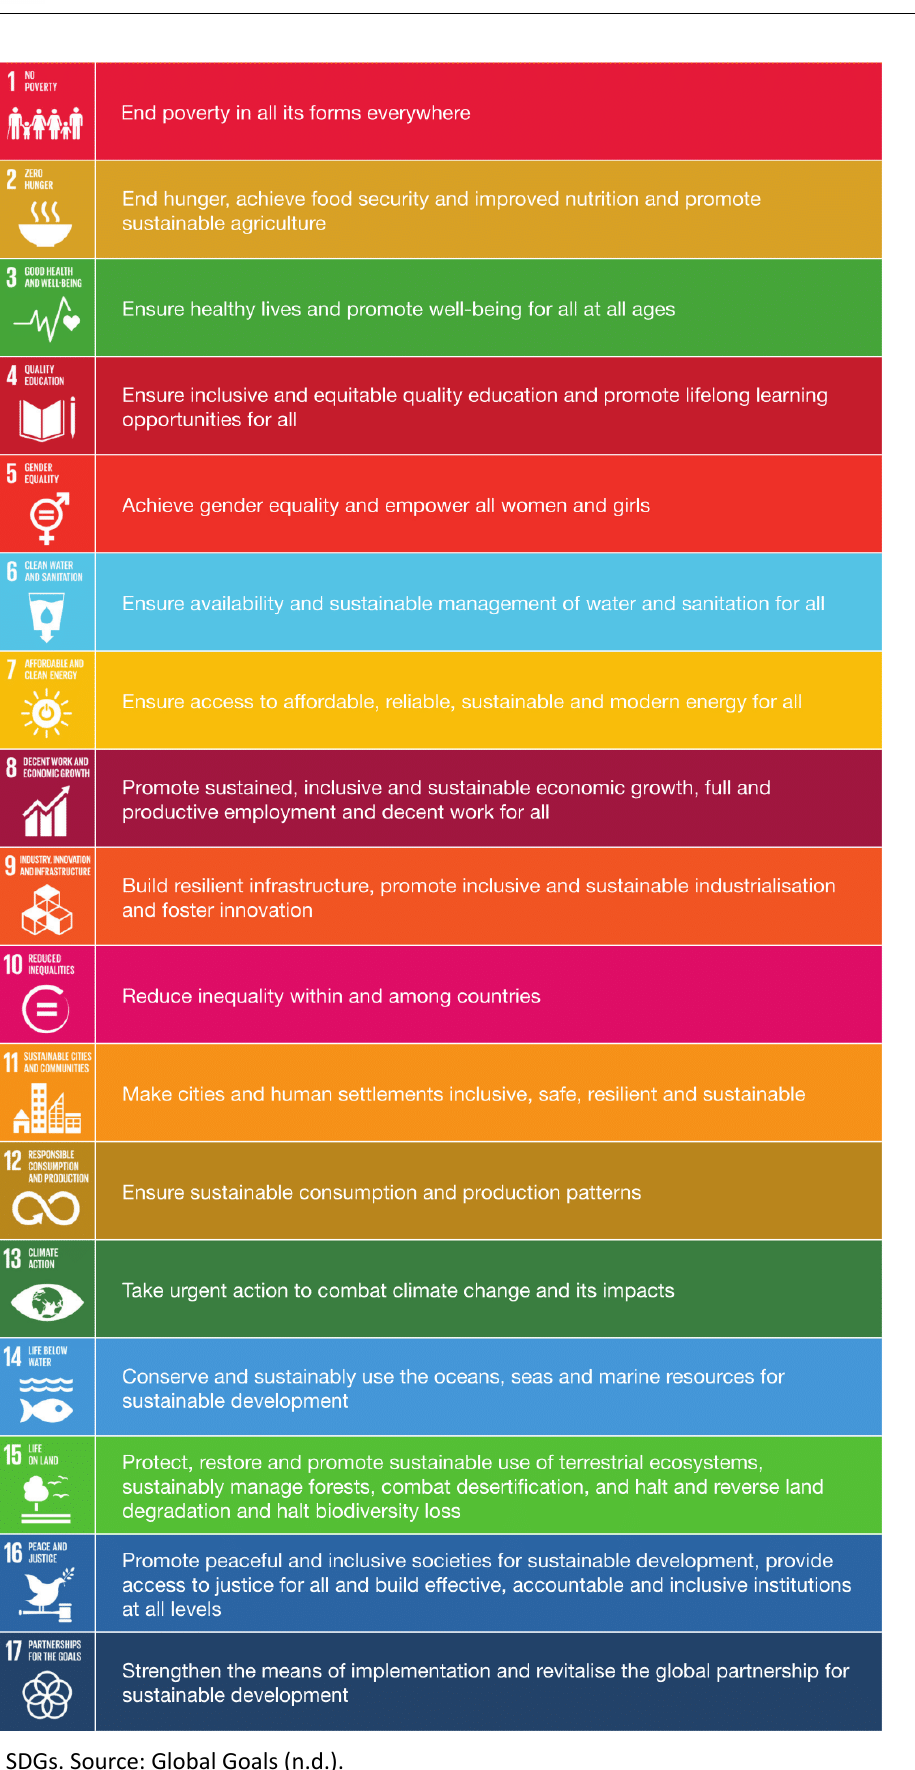
Figure 1. The UN SDGs. Source: Global Goals